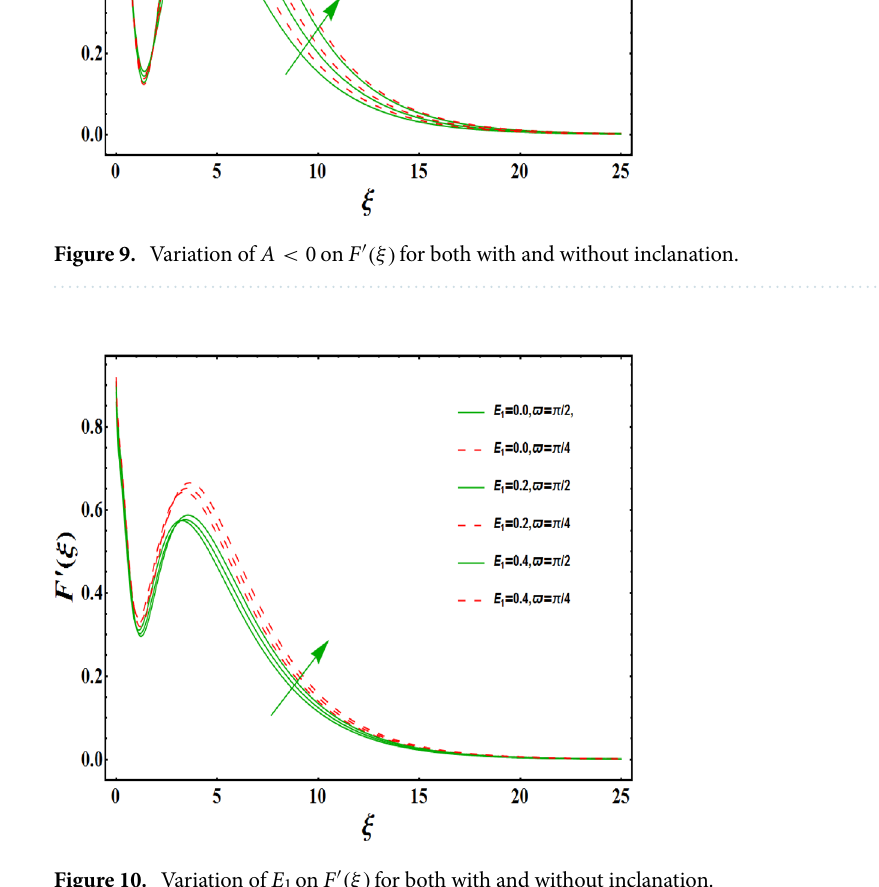
Figure 10. Variation of E 1 on F ′ (ξ) for both with and without